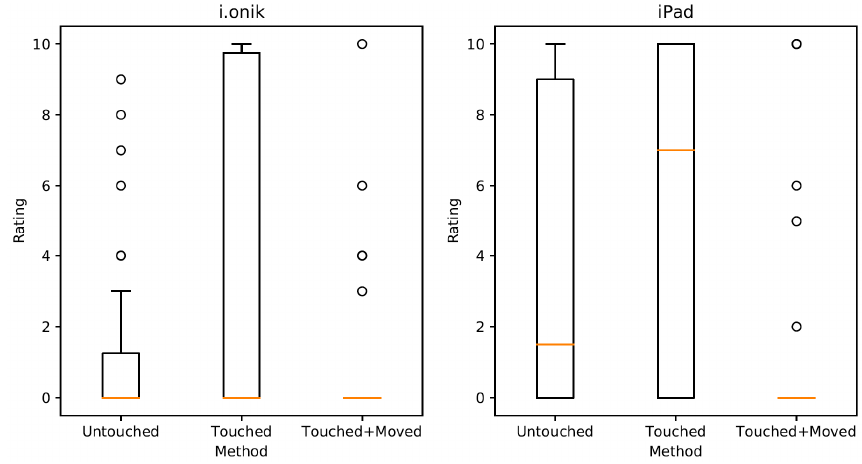
Figure 9. Comparison of detection performance (“Rating”) regarding different interaction methods on both devices.